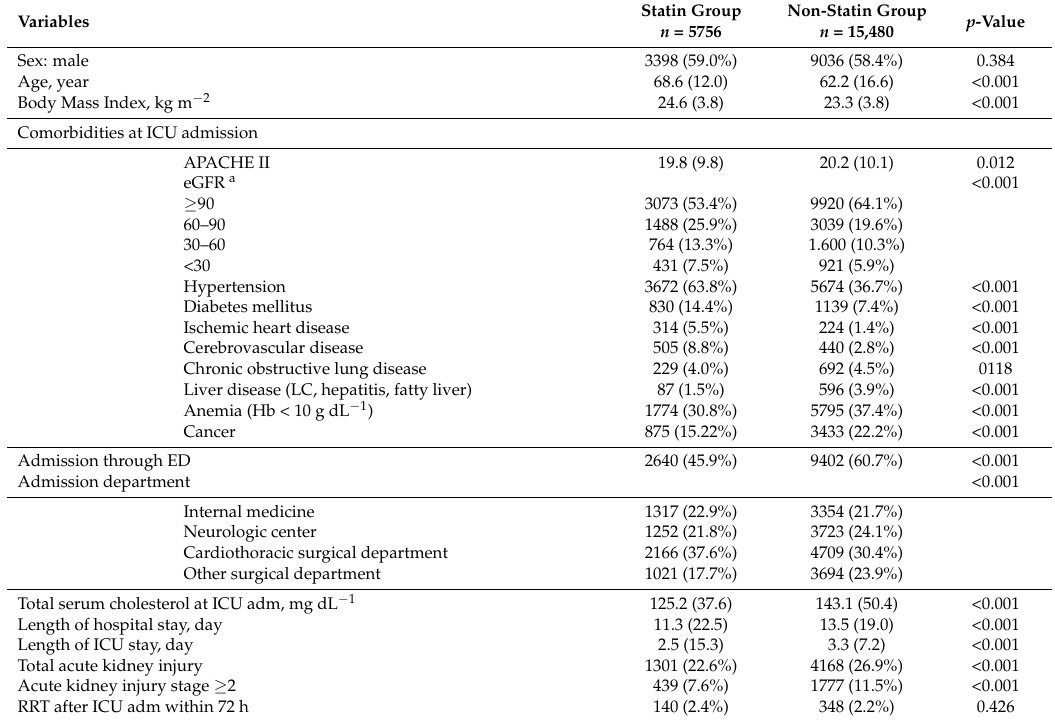
Table 2. Comparison of characteristics between preadmission statin user and non-statin user. Variables